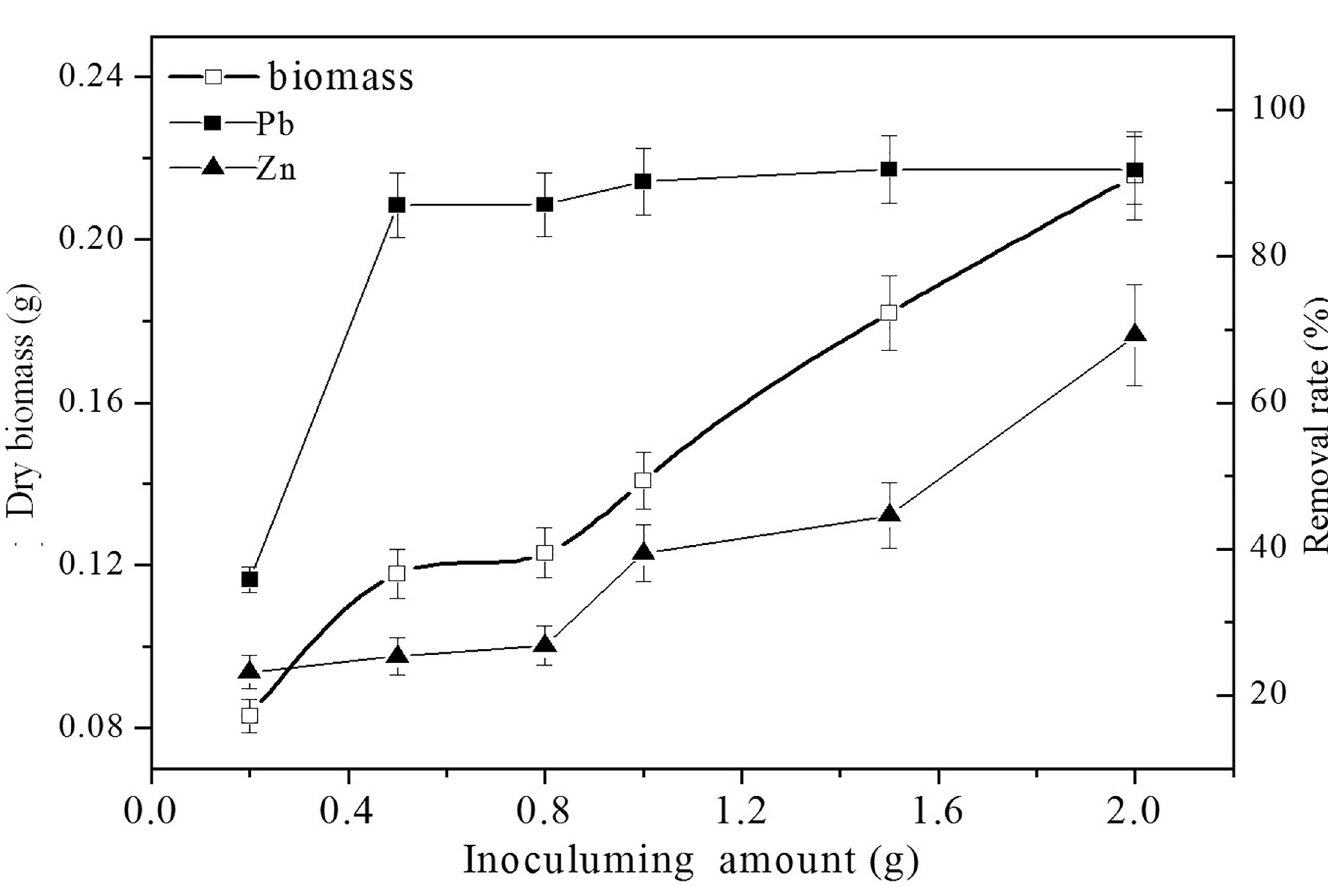
Fig 3. The effects of inoculum amount on biosorption. Biosorption conditions: initial pH = 4, initial Pb(II) and Zn(II) concentration in solution 250 mg L -1 , absorption time 7 days, temperature 30˚C. (Error bar represents means ± SE, P < 0.05, and n = 3).